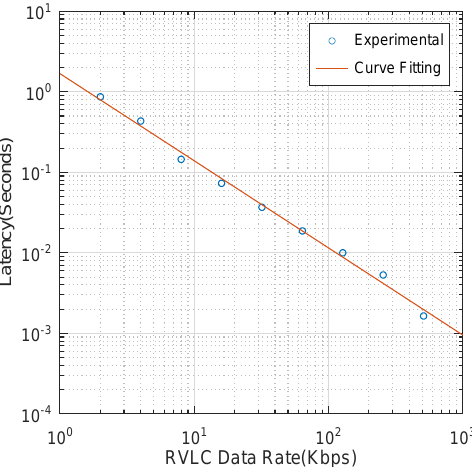
Figure 8. Retro-VLC uplink data rate vs key exchange latency showing the experimental results in blue and the curve fit used to extrapolate the expected time for other